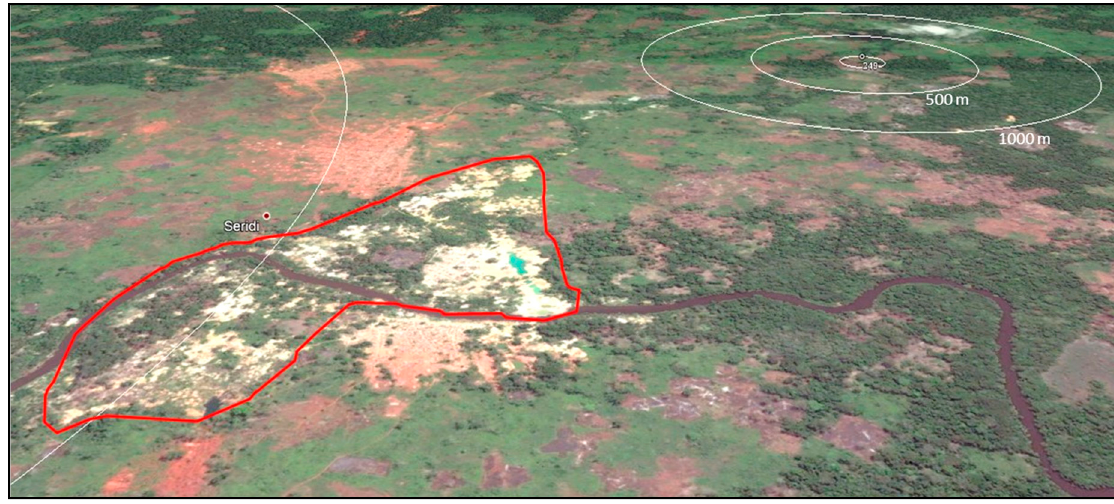
Figure 11. Gold mines (Oblique view) within 5km of sample 249, outlined in red, near Seridi, in the Bas-Uele Province, Bondo territoire (4°20 ′ 4.63 ″ N, 23°42 ′ 6.38 ″ E).